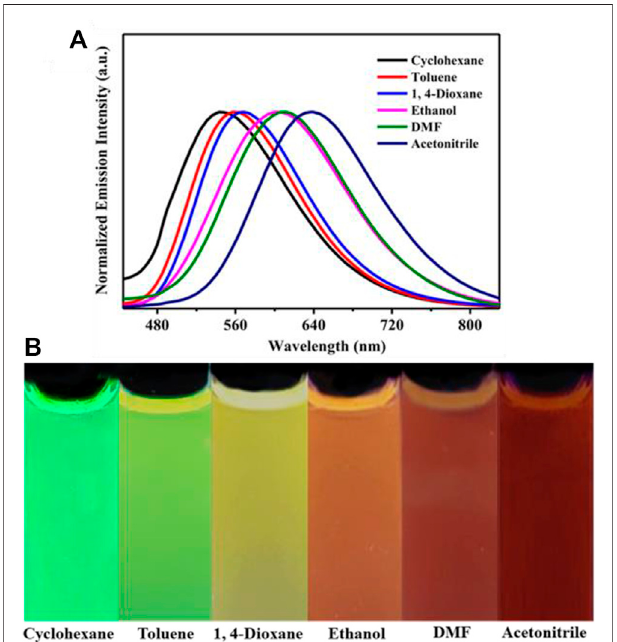
FIGURE 5 | (A) Normalized fl uorescence spectra (Excitation wavelength (cid:1) 365 nm) of compound 1 (2.0 × 10 − 5 mol L − 1 ) in different solvents. (B) PL imagesofcompound1(2.0 × 10 − 5 mol L − 1 )indifferentsolventsunder365 nm UV illumination.